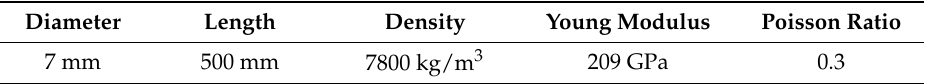
Table 2. The parameters of the transient FE simulation model.